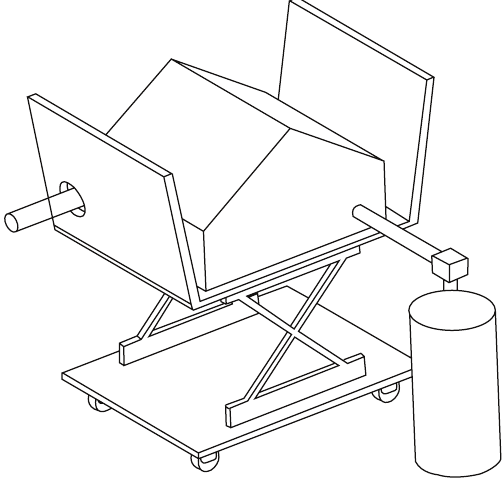
Figure 4: Prototype of the new solar